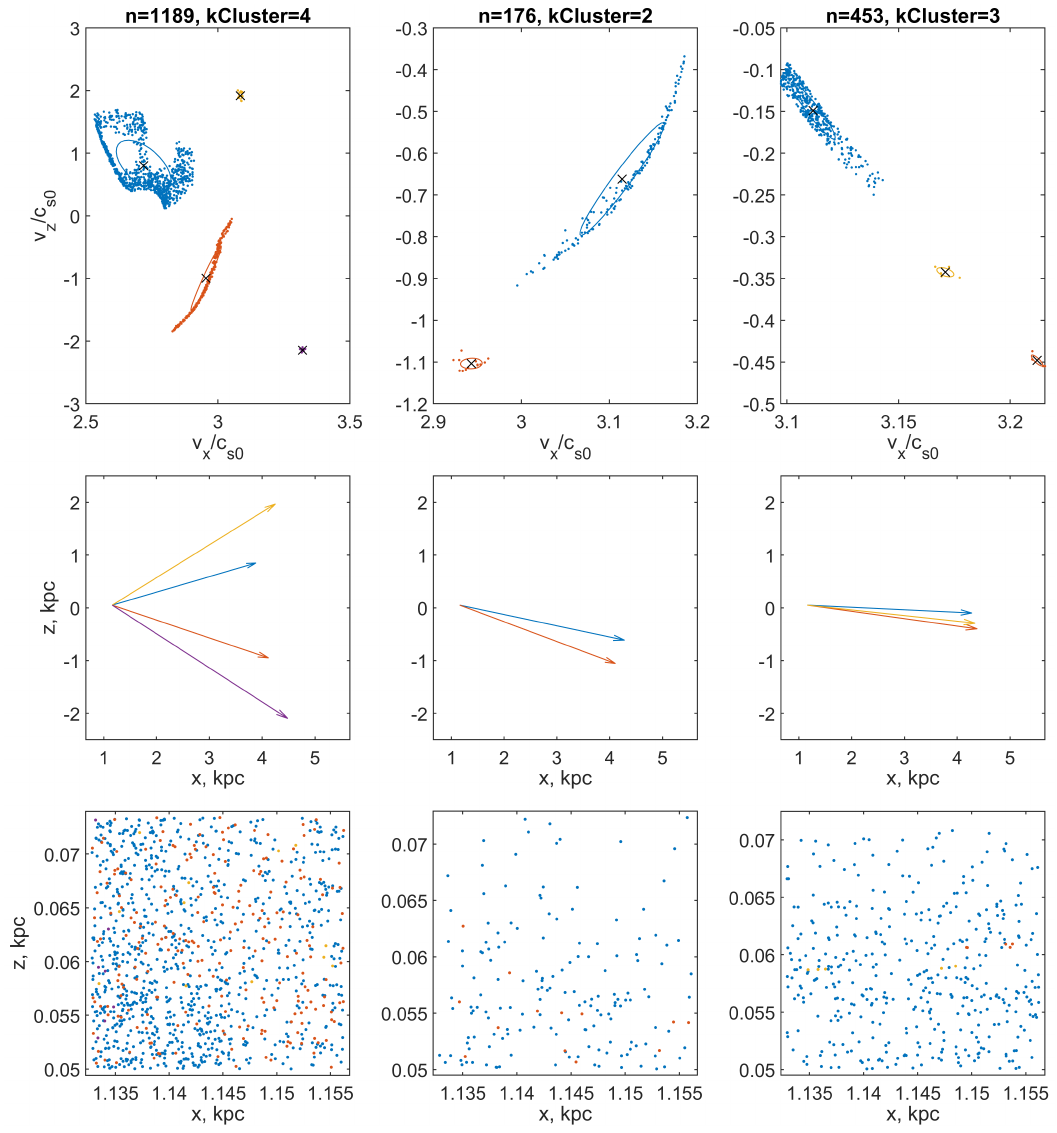
Figure 5. The same as in Figure 4, but for a cell with coordinates ( x = 1.160 kpc, z = 0.05